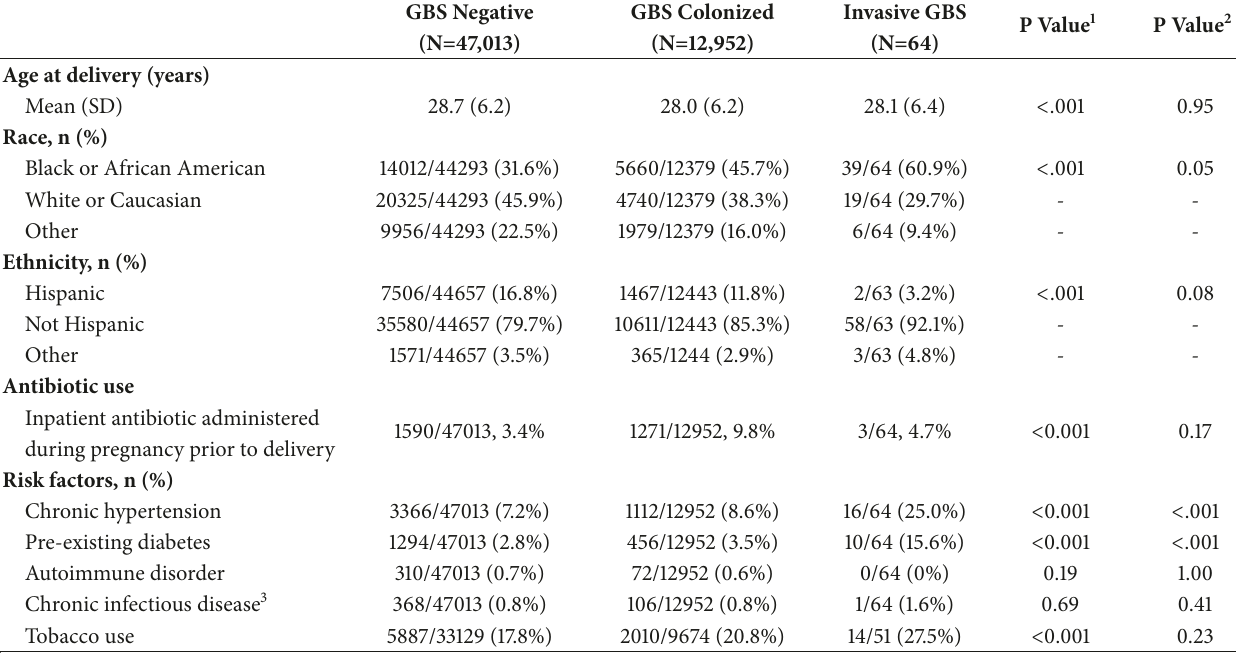
Table 1: Demographic and clinical characteristics by GBS